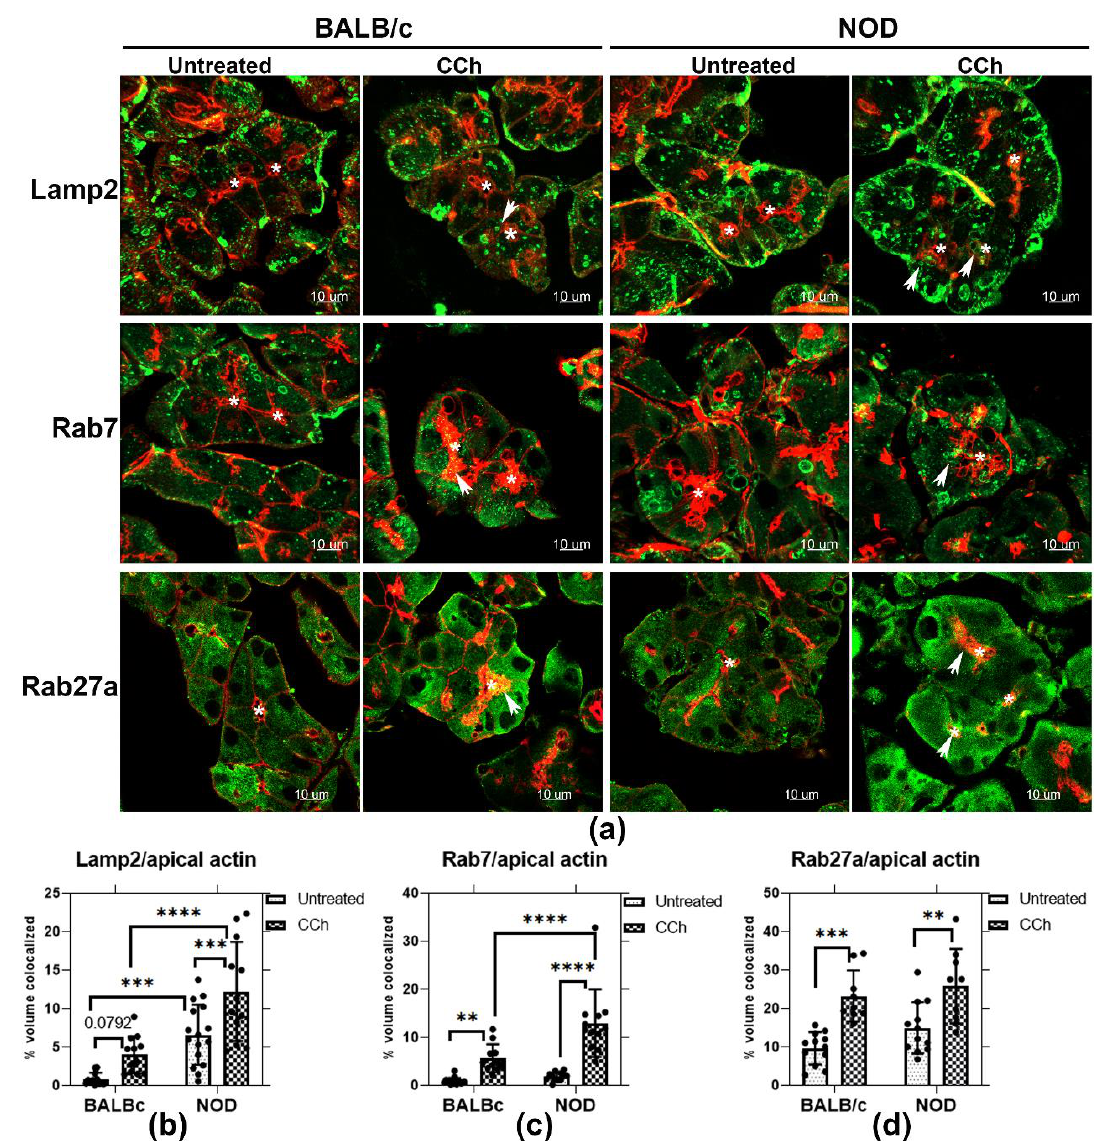
Figure 6. Rab27a and endolysosomal membrane marker colocalization with the apical actin meshwork. ( a ) Enrichment of the endolysosomal markers, Lamp2 and Rab7, as well as Rab27a were evaluated by indirect immunofluorescence in untreated and CCh-stimulated LG from male BALB/c and NOD mice. Z-projection images are shown for Lamp2, Rab7 and Rab27a (green) and the subapical actin meshwork, enriched immediately beneath the APM (red). Colocalization with the apical actin is demonstrated by arrows. ( b ) Lamp2 showed increased accumulation with apical actin in untreated LG of male NOD mouse, compared to LG from BALB/c mouse, with ***, p = 0.0003. In stimulated LG, Lamp2 colocalization with the apical actin meshwork increased by 2-fold in LG from male NOD, compared to LG from male BALB/c (****, p ≤ 0.0001). Lamp2 colocalization with the apical actin meshwork was increased in both male BALB/c ( p = 0.0792) and NOD (***, p = 0.0007) LG upon stimulation. ( c ) Rab7 colocalization with the apical actin meshwork was increased in both BALB/c (**, p = 0.0037) and NOD (****, p ≤ 0.0001) mouse LG with stimulation. Stimulated NOD LG sections also showed a 1-fold increase (****, p ≤ 0.0001) in colocalization with apical actin, relative to stimulated BALB/c LG sections. ( d ) Rab27a colocalization with the apical actin meshwork was increased in both BALB/c (***, p = 0.0001) and NOD (**, p = 0.002) mouse LG upon stimulation. However, no obvious differences were observed between the two strains with stimulation. N = 3–4, N = mice per group. Sections from each mouse LG were evaluated in three ROI per sample. All data are presented as mean ± SD. *, Lumen.